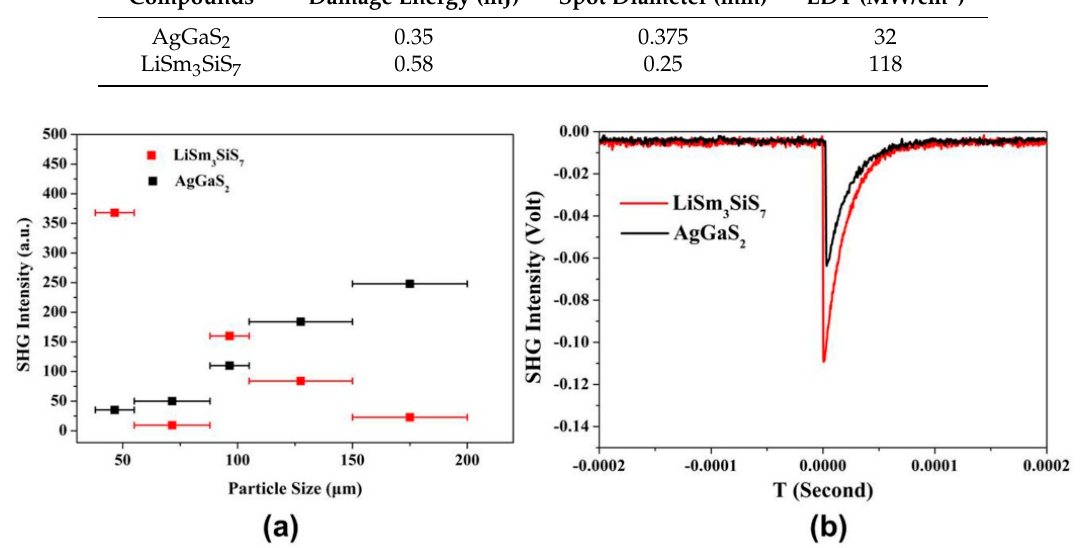
Figure 3. ( a ) Second-harmonic generation (SHG) intensity versus particle size for LiSm 3 SiS 7 and AgGaS 2 . ( b ) Comparison on SHG intensities for LiSm 3 SiS 7 and AgGaS 2 at the particle size (88–105 μ m). Particle Size ( µ m) Table 3. SHG intensity versus particle size for LiSm 3 SiS 7 and AgGaS 2 (as the reference).